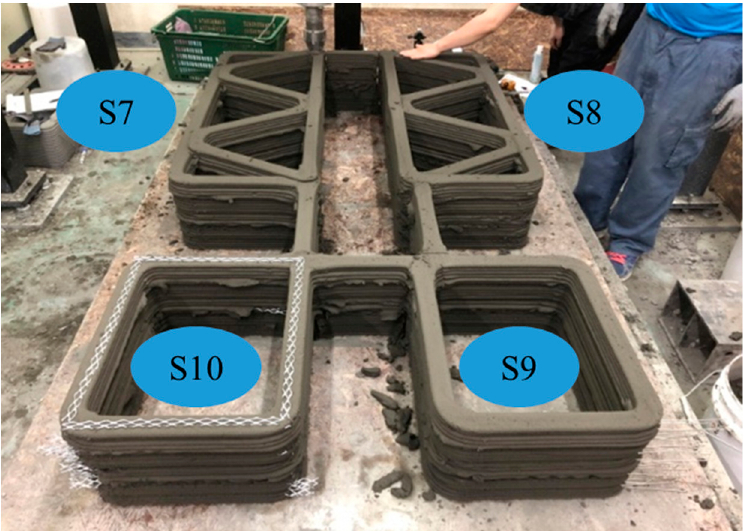
Figure 3. Simultaneous printing of structures S7, S8, S9, and S10.